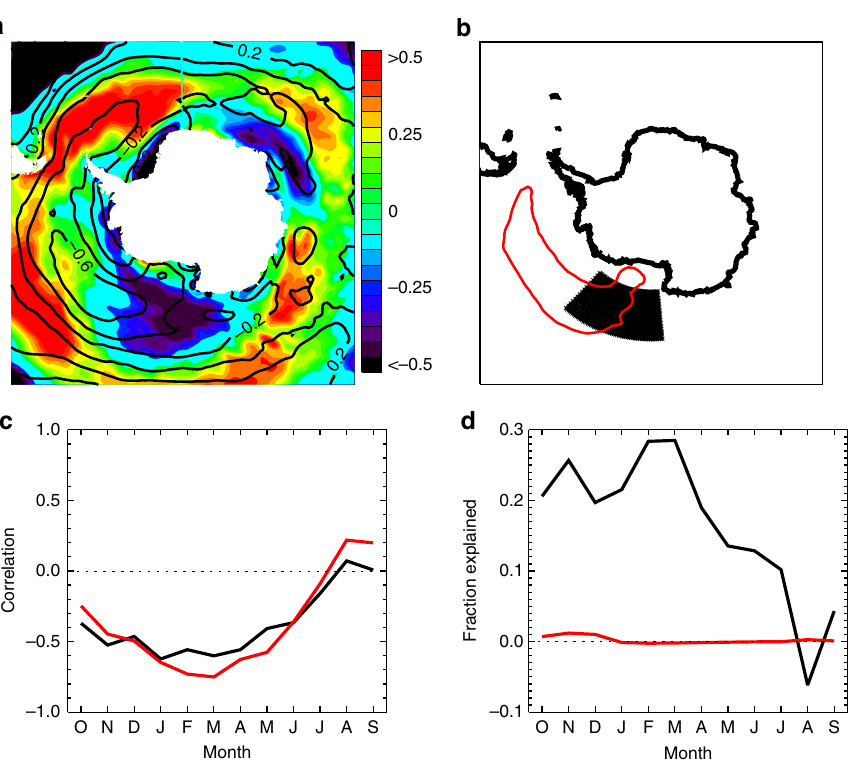
Fig. 5 Attribution of western Ross Sea ice area trends to the October zonal winds trends. a Trends in gridded October zonal winds for 1979 – 2015 from ERA-Interim in the colored shading in units of m s – 1 per decade. Black contours indicate the correlation of the October zonal wind index and March western Ross Sea ice area (as also shown in Fig. 1d). b The two regions used for averaging the zonal wind anomalies. c The correlation of monthly western Ross Sea ice area and October zonal wind anomalies averaged for the two regions shown on b . d The fraction of the observed monthly trend in western Ross Sea ice area that is attributable to the October zonal wind trend averaged for the two regions. In c and d , the color of the line corresponds to the use of wind data that is averaged for the associated colored region in